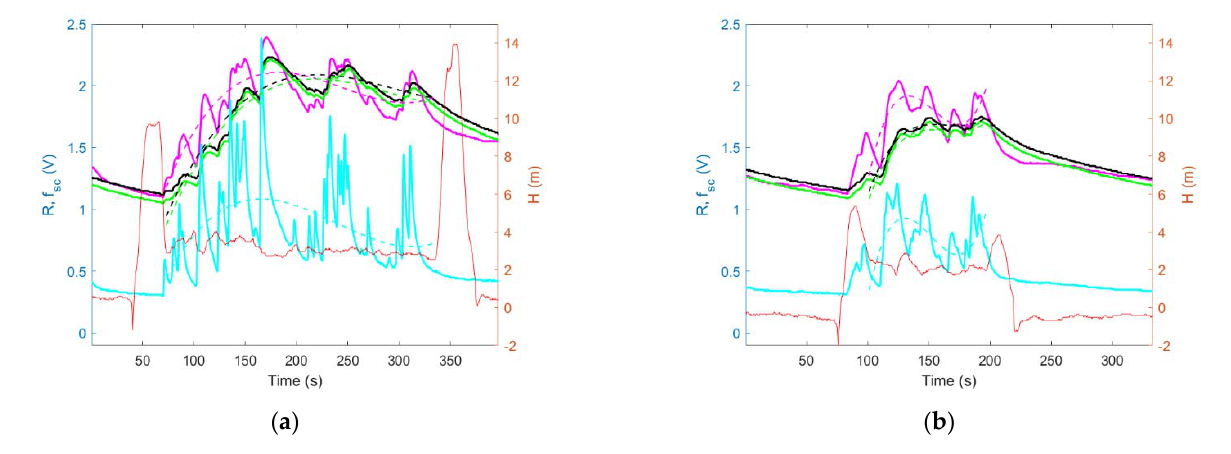
Figure 13. Results of measurements performed by the sensing drone during experiment CE1, when the sensing platform was: ( a ) lowered from the drone, ( b ) docked under the drone. Gas sensor signals are shown using solid lines: GM102B (magenta), GM302B (black), GM502B (green), and GM702B (cyan). The systematic components of sensor signals are shown using dashed lines, respectively. A solid red line indicates the sensing platform height above the ground.